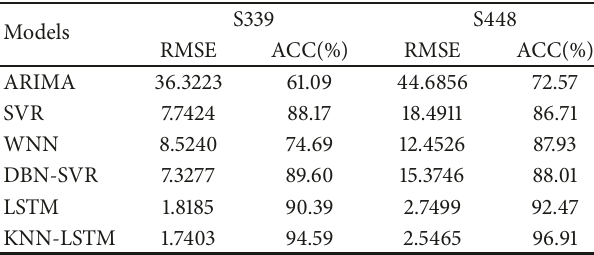
Table 1: Prediction performances of different